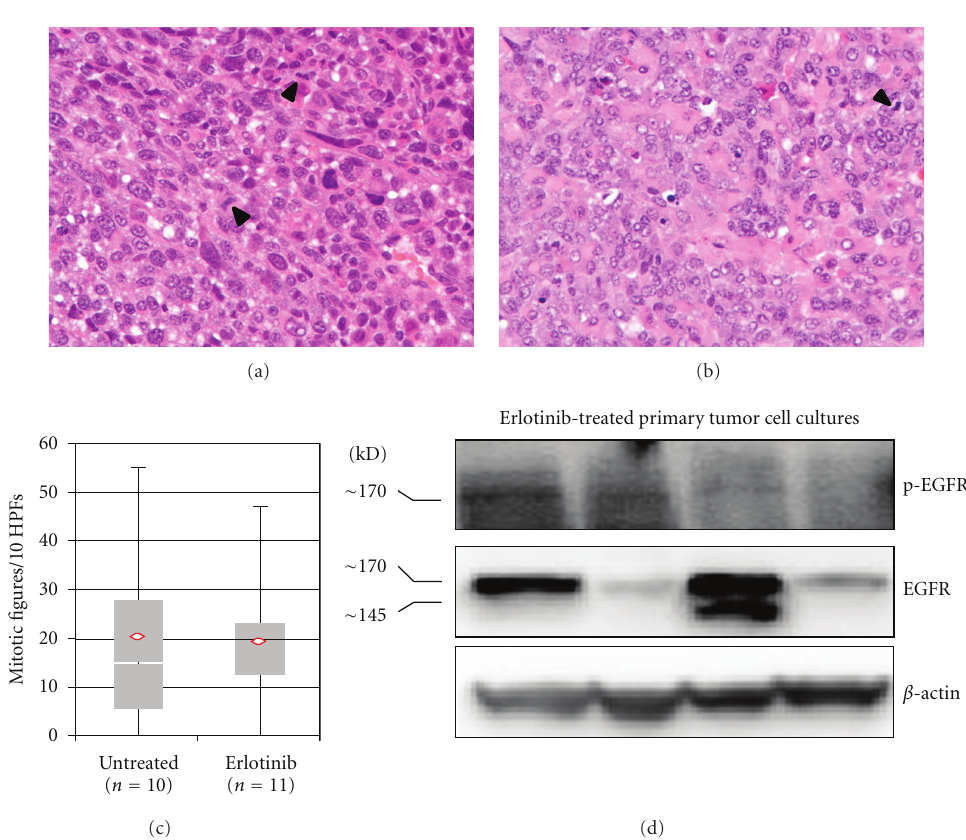
Figure 3: Histological and biochemical analysis of untreated and Erlotinib-treated tumors. Representative histology of (a) untreated and (b) Erlotinib-treated tumors. (c) Mitotic figures/10 high-power fields for untreated and Erlotinib-treated mice ( P = 0 . 841). (d) Western blots showing the expression and phosphorylation of Egfr in primary tumor cell cultures from Erlotinib-treated